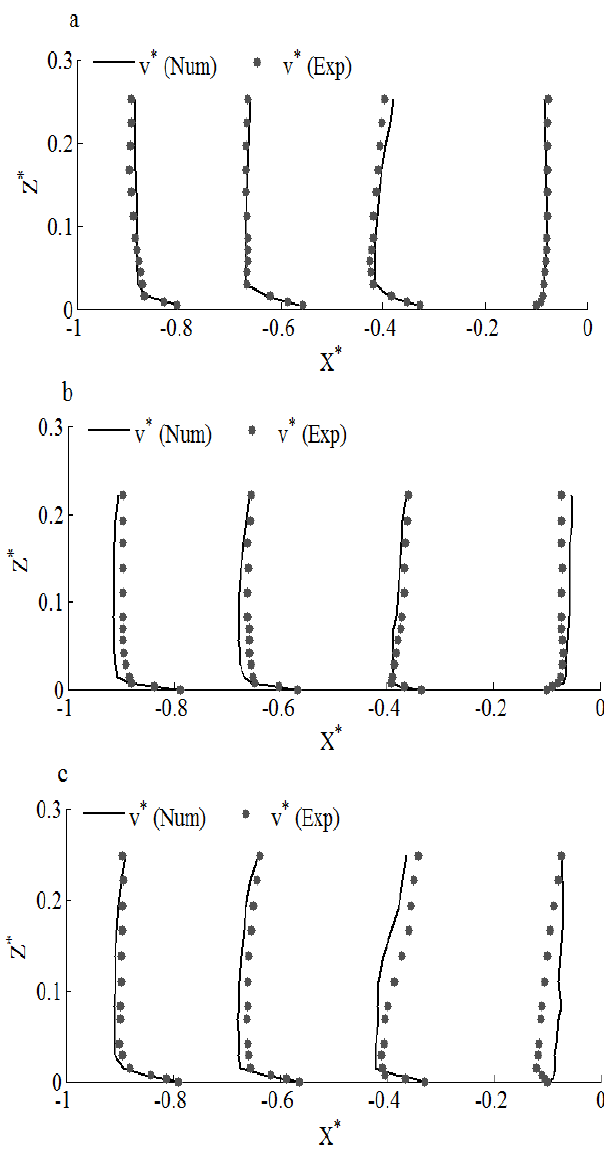
Figure 5. Verification graphs between the results of the CFX model and the Ramamurthy and his colleagues’ experimental model in: ( a ) y* = − 0.29, ( b ) y* = − 1.00, and ( c ) y* = − 1.62.